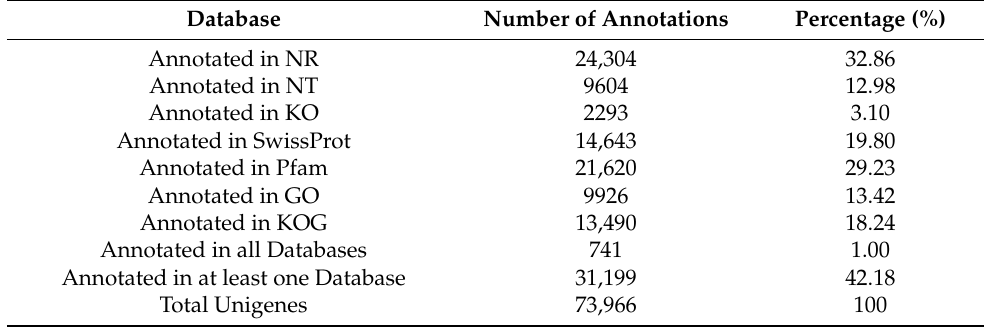
Table 3. Numbers of all annotated unigenes of P. quatuordecimpunctata in seven